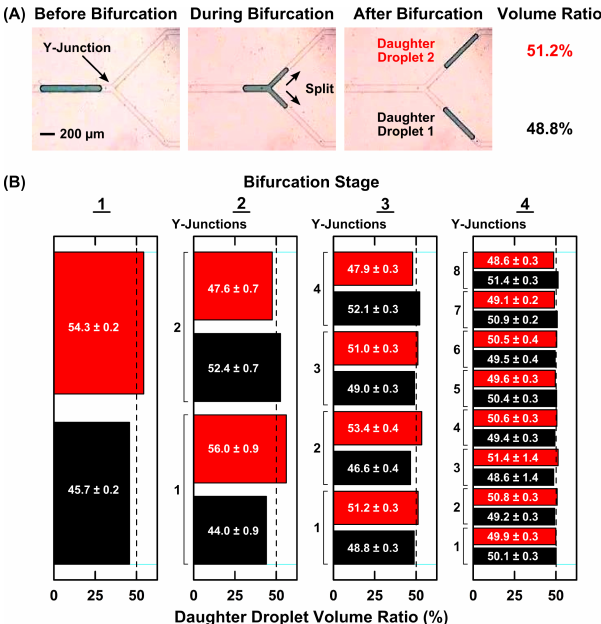
Figure 3. Uniformity of Droplet Bifurcation. ( A ) In our device, microfluidic droplets split into two equal halves as they flow through a bifurcating Y-junction. To quantitatively analyze the bifurcation performance at the Y-junction, we determine the volume of the pair of daughter droplets after splitting and calculate the ratio of the volume of each daughter droplet over the combined volume of the two droplets; ( B ) We measured ~50% volume ratio for all daughter droplets across the four bifurcation stages and the 15 Y-junctions ( n = 10 for each Y-junction), suggesting that uniform droplet bifurcation is independent of channel dimensions and droplet volumes.